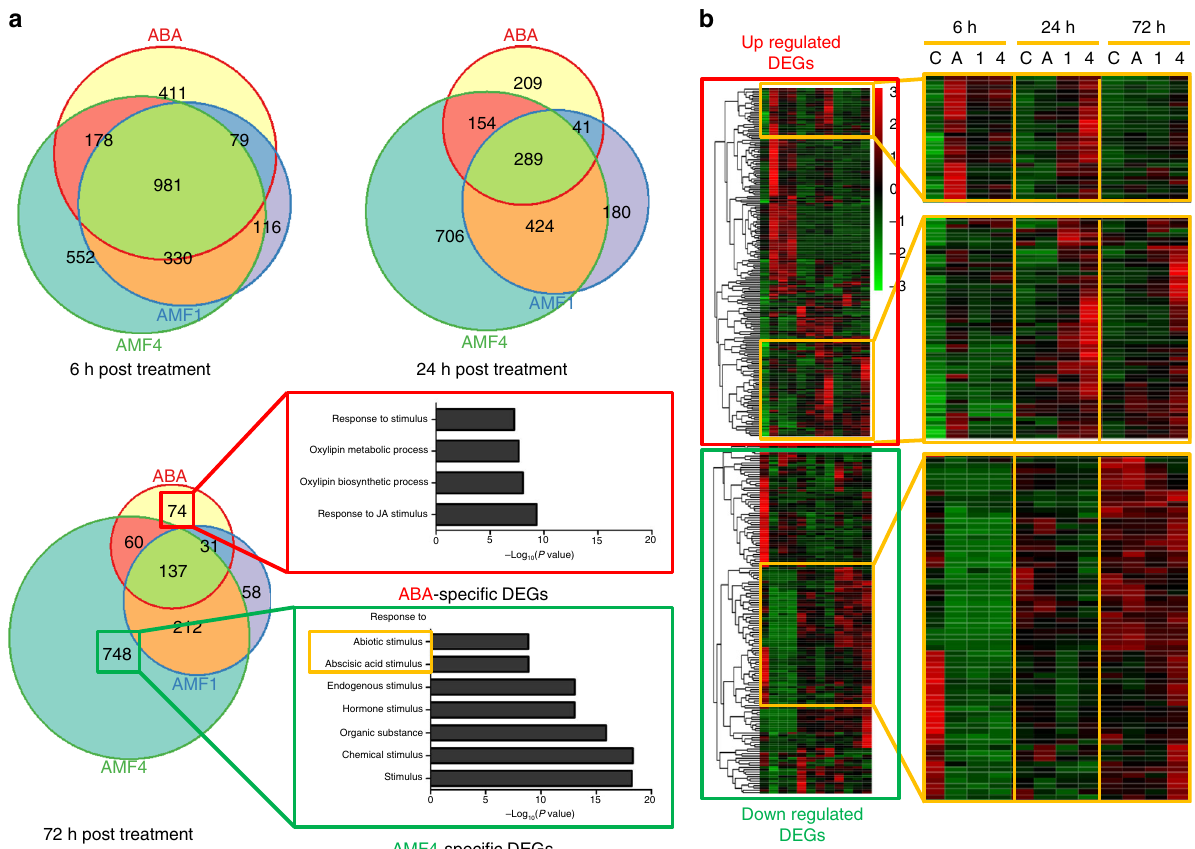
Fig. 4 AMFs regulate ABA-responsive genes in Arabidopsis plants. Col-0 plants are sprayed with 10 μ M (+)-ABA (ABA or A), AMF1 β (AMF1 or 1), or AMF4 (AMF4 or 4) are sampled 6, 24, and 72 h post treatment, and DMSO (DMSO or C) is used as the control. Gene expression pro fi les are based on RNA-seq results. a Overlap of ABA- and AMFs-induced DEGs. AMF1 β or AMF4 induce highly correlated responses at the transcript level compared with ABA. Ontology analysis of ABA- or AMF4-speci fi c DEGs shows that some ABA- or abiotic stress-related processes are still among the most enriched biological processes (based on their P values) at 3 days after AMF4 treatment but not at 3 days after ABA treatment. b Heat map of ABA- or abiotic stress-related DEGs in Col-0 plants. DEGs are clustered based on expression pro fi les. Each row contains an ABA- or abiotic stress-related DEG based on gene ontology analysis. Each column represents a chemical-time combination. The DEGs showing divergent time-course response to ABA or AMFs are highlighted. The color in each cell indicates its relative expression level compared to the mean expression level in all samples of the same row according to the color bar, with red and green representing upregulated and downregulated genes,